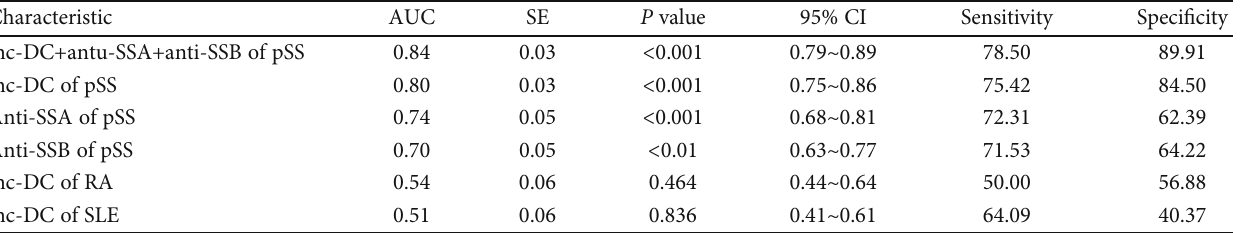
Table 3: lnc-DC alone or lnc-DC combined with anti-SSA and anti-SSB for the discriminative ability of pSS patients from HC and other autoimmune disease such as SLE and RA.